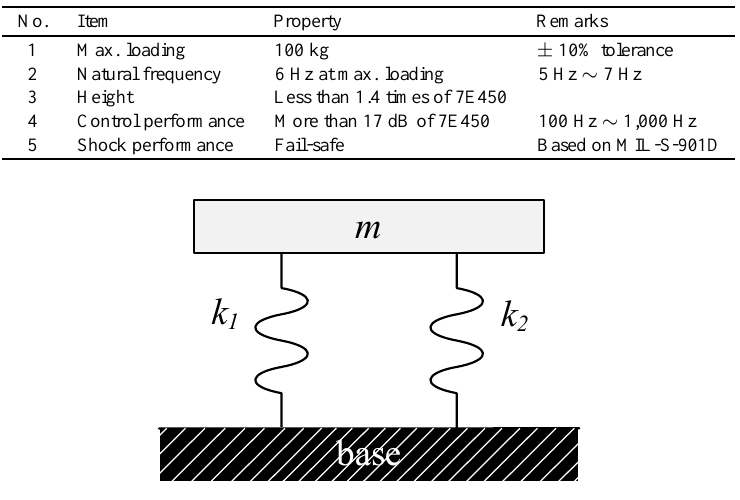
Fig. 1. Schematic diagram of two springs in parallel.